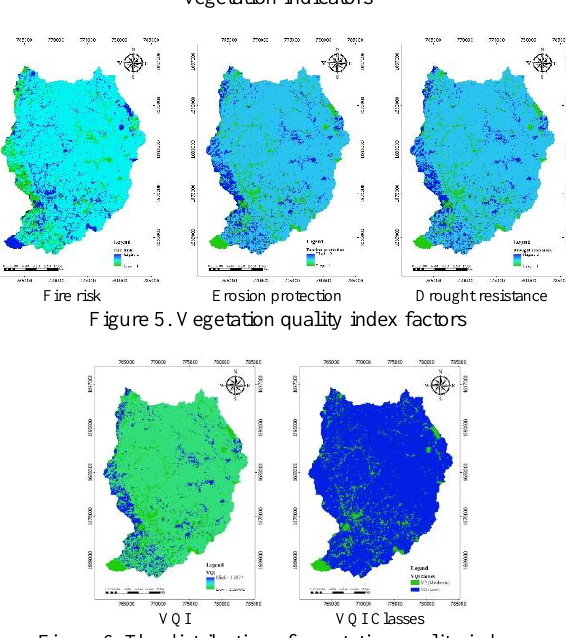
Figure 3 Soil quality index factors.